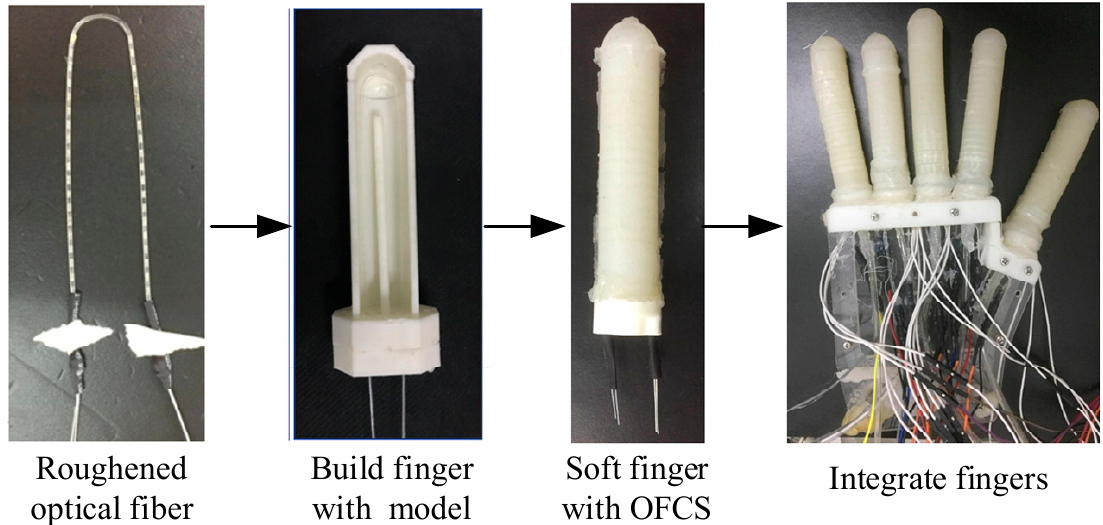
Figure 2. The procedure of integrating OFCS in soft robotic hand. The GPS is embedded in a proportional valve, which is used to measure the absolute pressure of gas and connected in the gas channel of each finger in series mode. The proportional valve (ITV2030-312CS, SMC, Inc., Tokyo Metropolis, Japan) is able to pass pressure of 0.5 Mpa. The control signal is an analog signal with DC 0–10 V, and the analog output signal DC 1–5 V reflects the gas pressure in the gas channel in a linear relation. The OFCS and GPS are used to detect the curvature of the finger. The gesture is recognized by merging the sensor information of five fingers. The gesture detection is compared with the action of SRH to validate the action trigger is in the correct